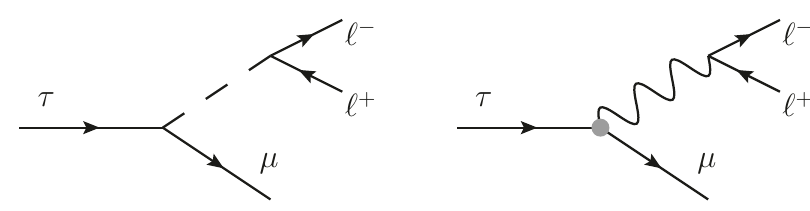
(cid:22)‘ + ‘ (cid:0) decays. The diagram on the right arises from !